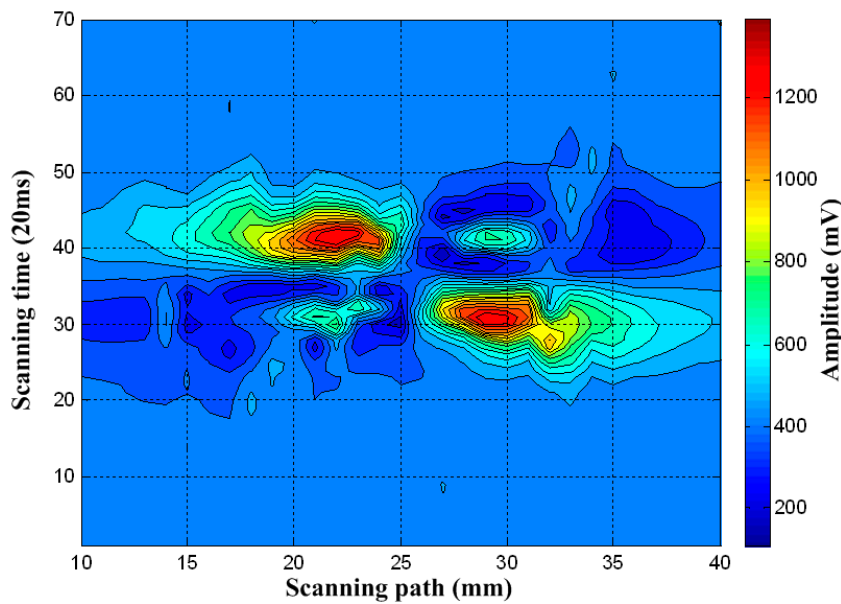
Figure 6. The original C-scan contour images of defect 1.